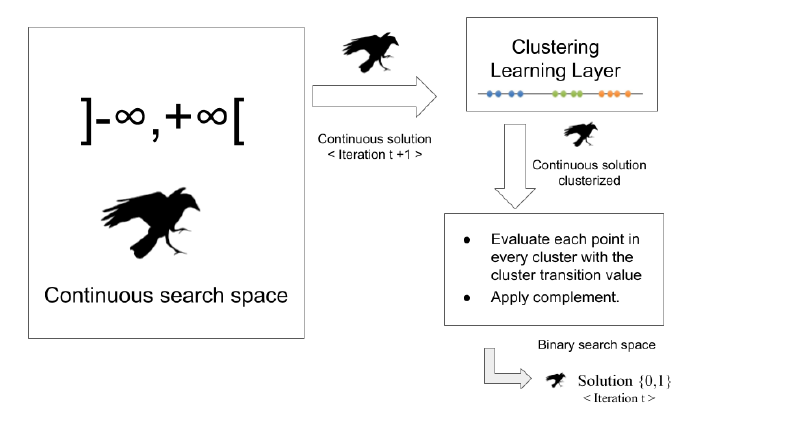
Figure 4. Continuous to Binary KMeans.